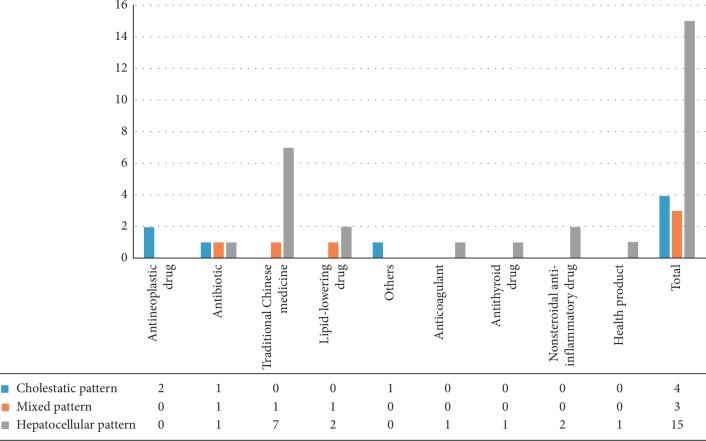
Patterns of liver injury in patients with simultaneous liver and kidney injuries.